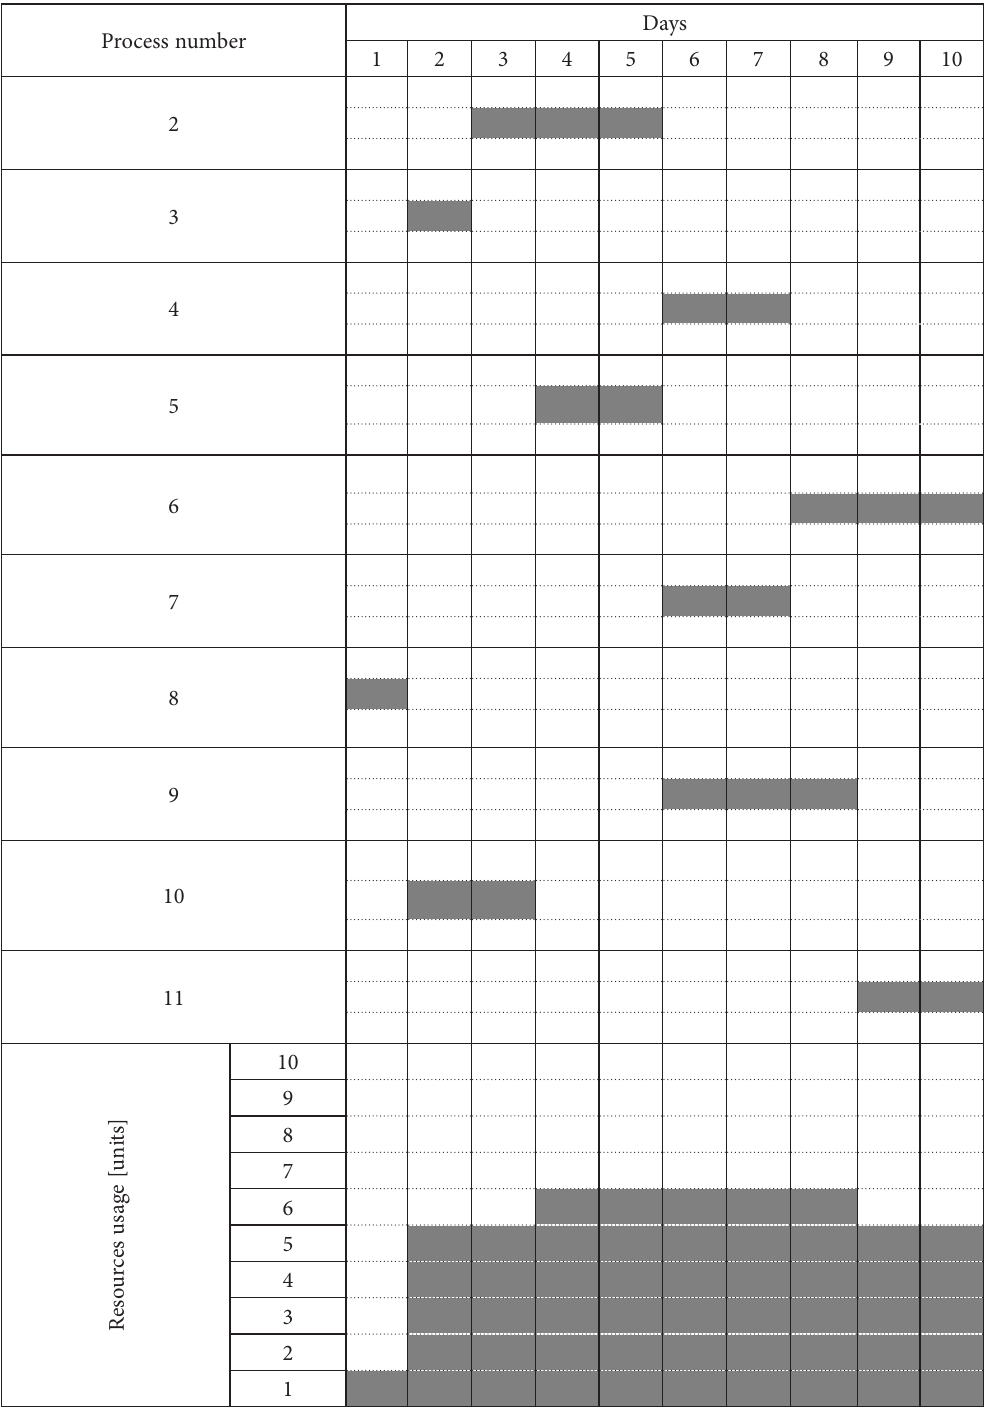
Figure 3. Project schedule and resource utilization profile for the optimal solution (weakening soft precedence relation